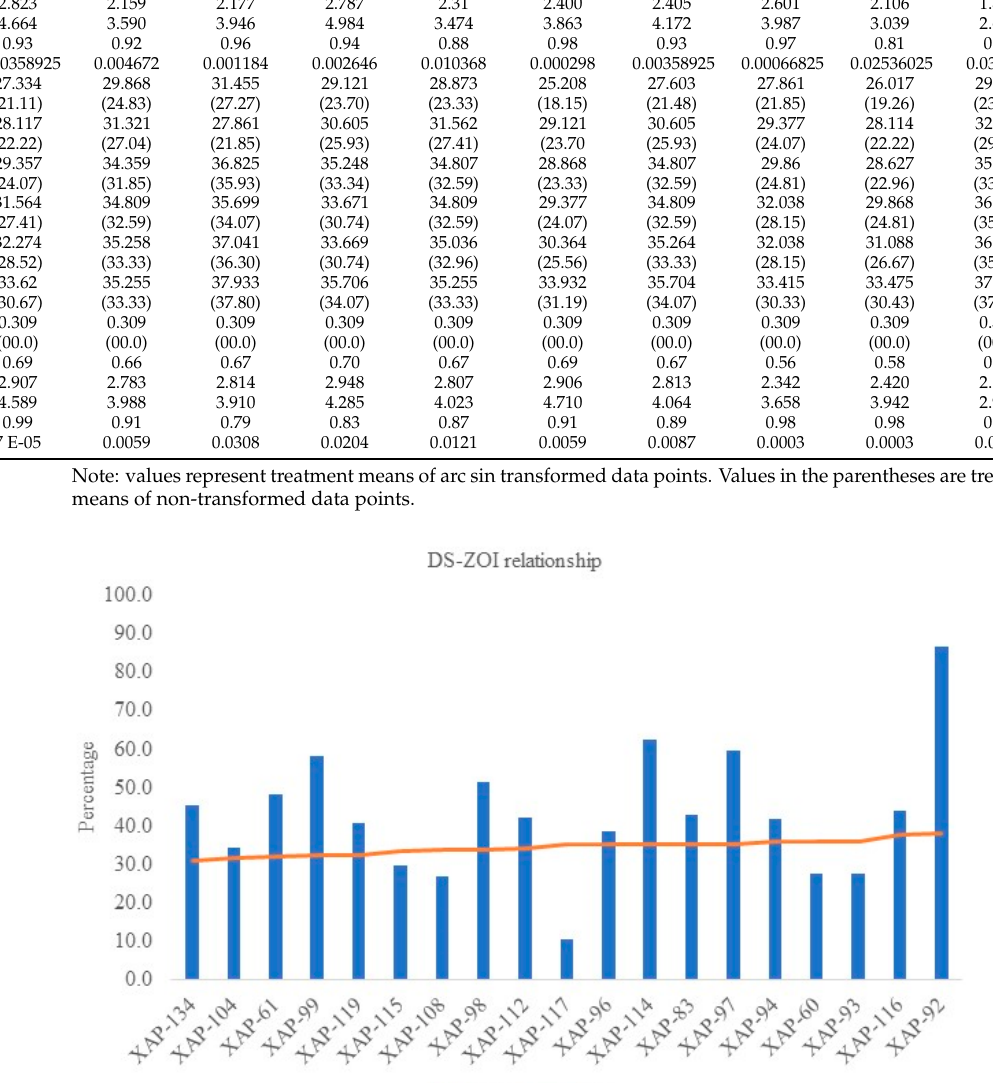
Figure 5. Multiple sequence alignment of rpsL nucleotide fragment amplified from Xap isolates and the reference sequence retrieved from NCBI database.